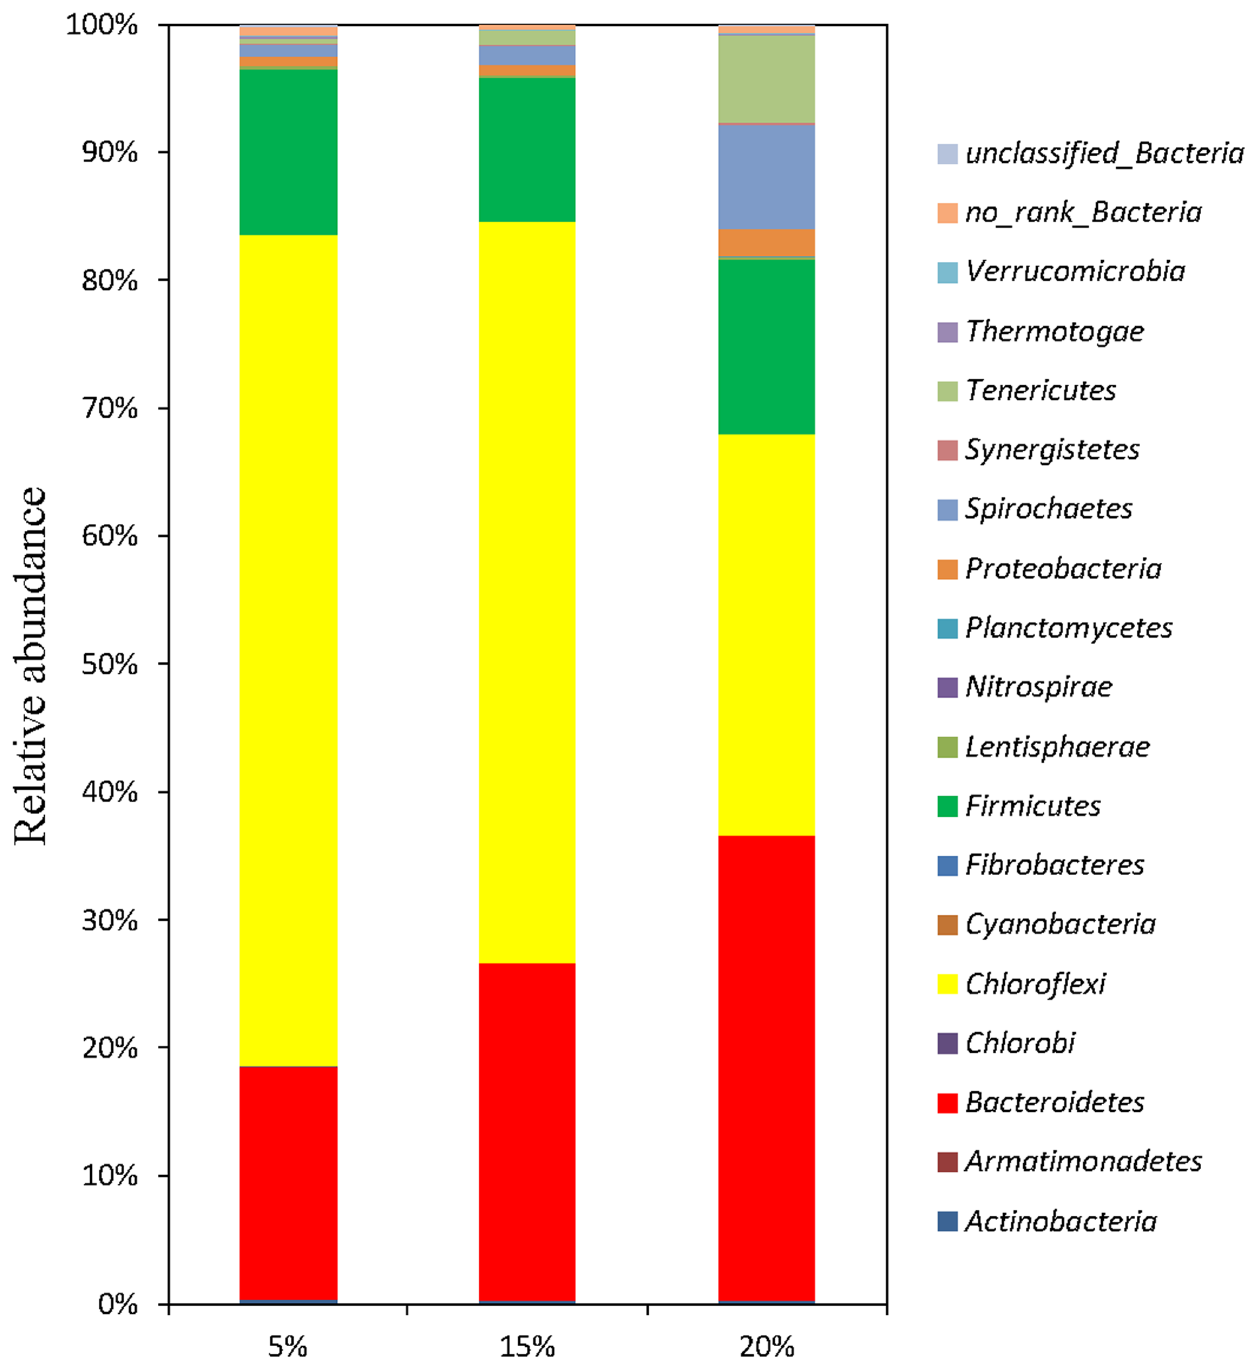
Figure 1. Taxonomic compositions of bacterial communities at phyla level in each sample retrieved from pyrosequencing.